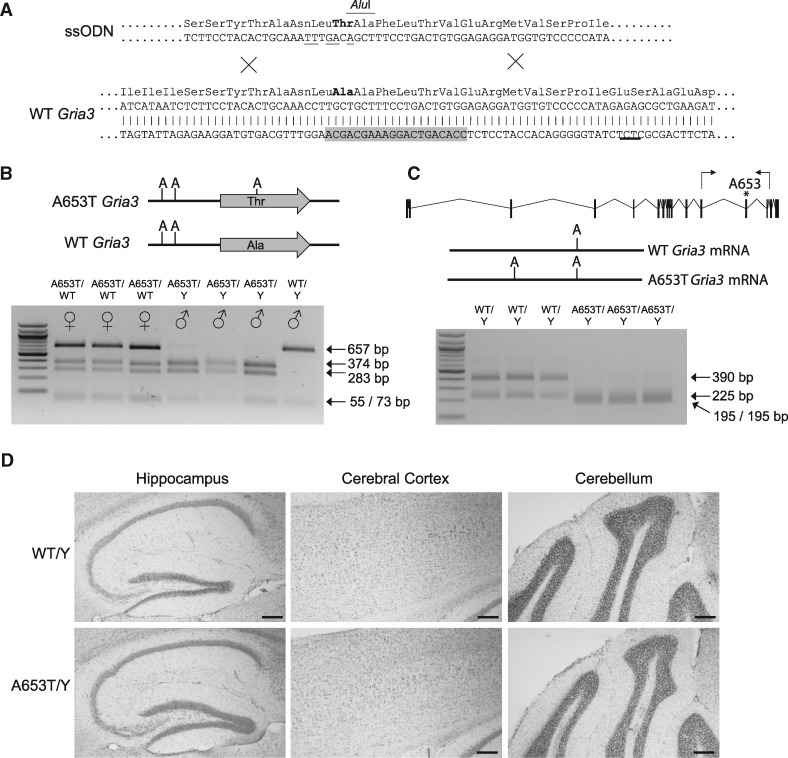
Generation of the Gria3A653T mouse model. (A) Bottom panel shows the wild-type Gria3 sequence with the position of the target amino-acid shown in bold. The protospacer target used for the CRISPR-Cas9 nuclease design is highlighted in grey. Top panel shows detail of the ssODN used to introduced the desired amino-acid change, along with silent mutations (underlined) to mark the recombined allele with an AluI restriction site and mutate the Protospacer Adjacent Motif. (B) Top panel shows the genotyping amplicon obtained from the Gria3A653T and wild-type Gria3 alleles with the position of the AluI restriction enzymes marker. Lower panel shows an example of the digestion of the amplicon obtained from heterozygous Gria3A653T/WT (A653T/WT) female, hemizygous Gria3A653T (A653T/Y) and wild-type (WT/Y) male mice. (C) Top panel shows the genomic structure of Gria3 with the position of the primers used for RT-PCR analysis marked. Middle panel shows the pattern of AluI restriction sites in the amplicons obtained from wild-type and A653T cDNA. Lower panel shows the AluI digestion products obtained following ampicon digestion obtained from hemizygous Gria3A653T (A653T/Y) and wild-type (WT/Y) male mice. (D) Micrographs of Nissl stained sagittal brain sections from wild-type and hemizygous Gria3A653T mice in regions of the brain where Gria3 is highly expressed. Scale bars: 200 μm.